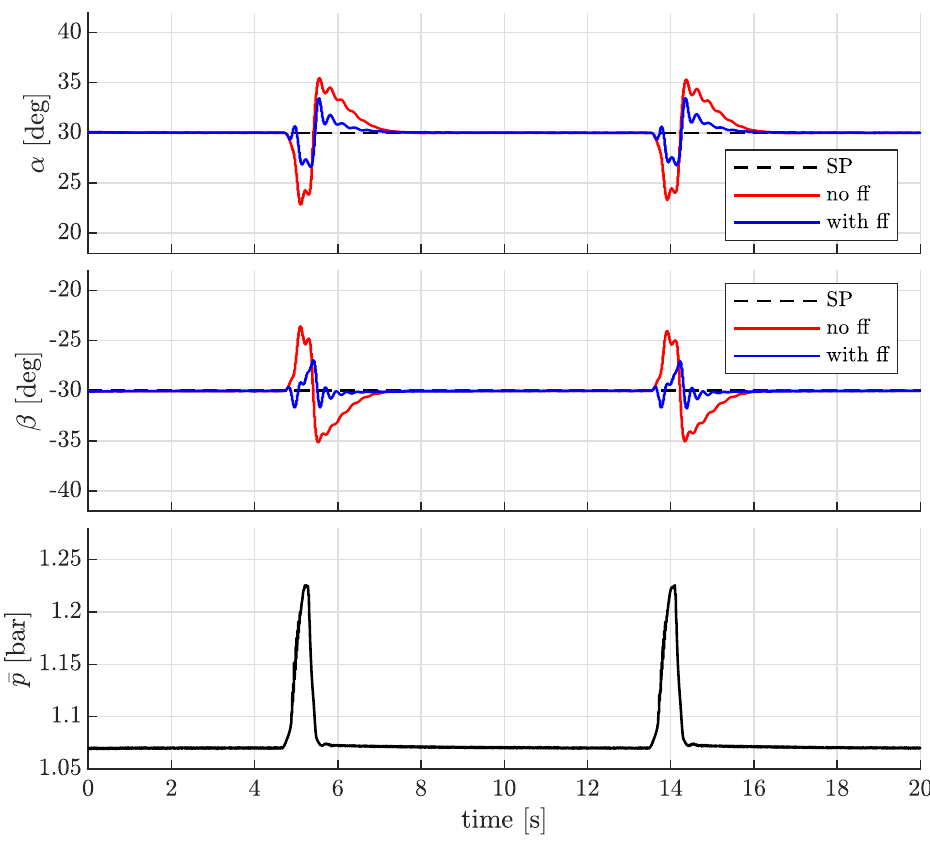
Figure 17. The lower pressure level, ¯ p , as shown in the bottom plot, is rapidly increased to cause a longitudinal elongation for grasping an object. The top and middle plots show a comparison of the angles α and β when no feed forward (ff) control action is used (red curve) and when the proposed feed forward strategy is employed (blue curve). Relying on the feed forward approach reduces the maximum error in α from 7.1deg to 3.5deg and in β from 6.4deg to 3.0deg. In the case where